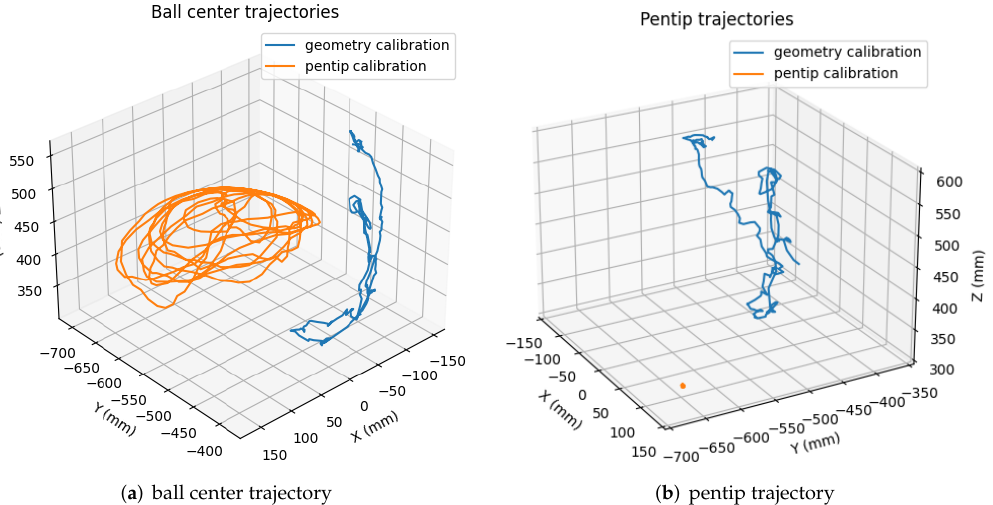
Figure 11. Pen position trajectories w.r.t. robot base coordinate in geometry and pentip